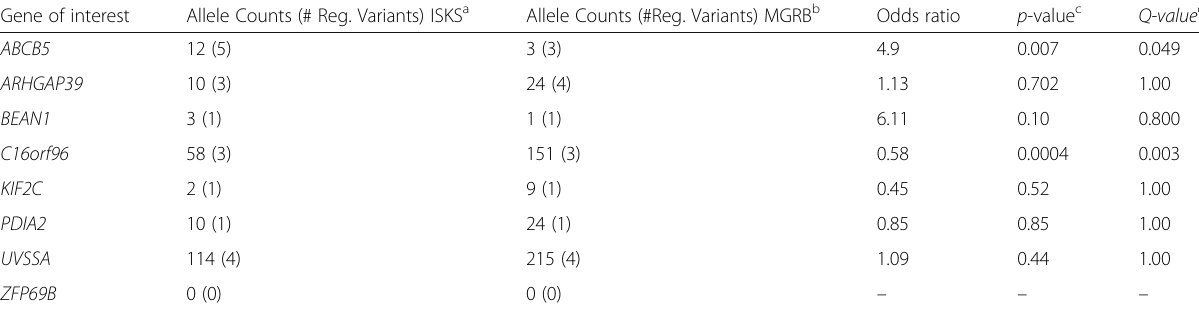
Table 5 Minor allele counts for rare putative regulatory variants, odds ratios and p -values from Fisher ’ s exact test for genes of interest Gene of